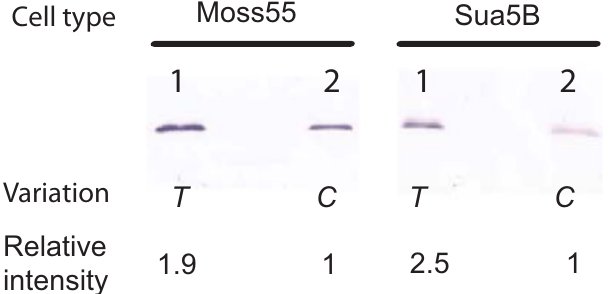
Figure 4. Expression efficiency of two variants of FBN30 in mosquito cell lines. Moss55 cells(left) and Sua5B cells(right) were the mosquito cells transfected with vector. After transfection assays with the same amount of recombinant plasmids containing either FBN30 ( T ) or ( C ), the western blot assays detected one specific band corresponding to the recombinant FBN30 protein. The band intensity was measured with Image J software. The expression ratios of FBN30 ( T ) to ( C ) were 1.9 and 2.5 folds in Moss 55 and Sua5B